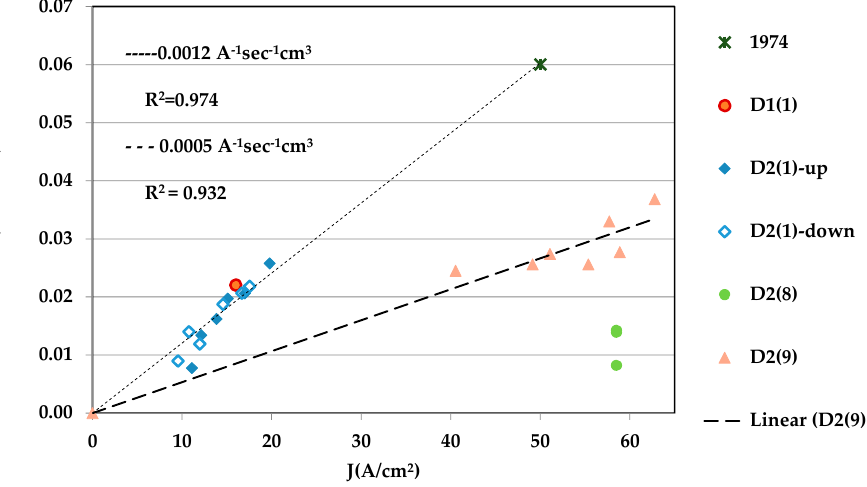
Figure 7. Sliding velocity as function of current density in samples of VO 2 .